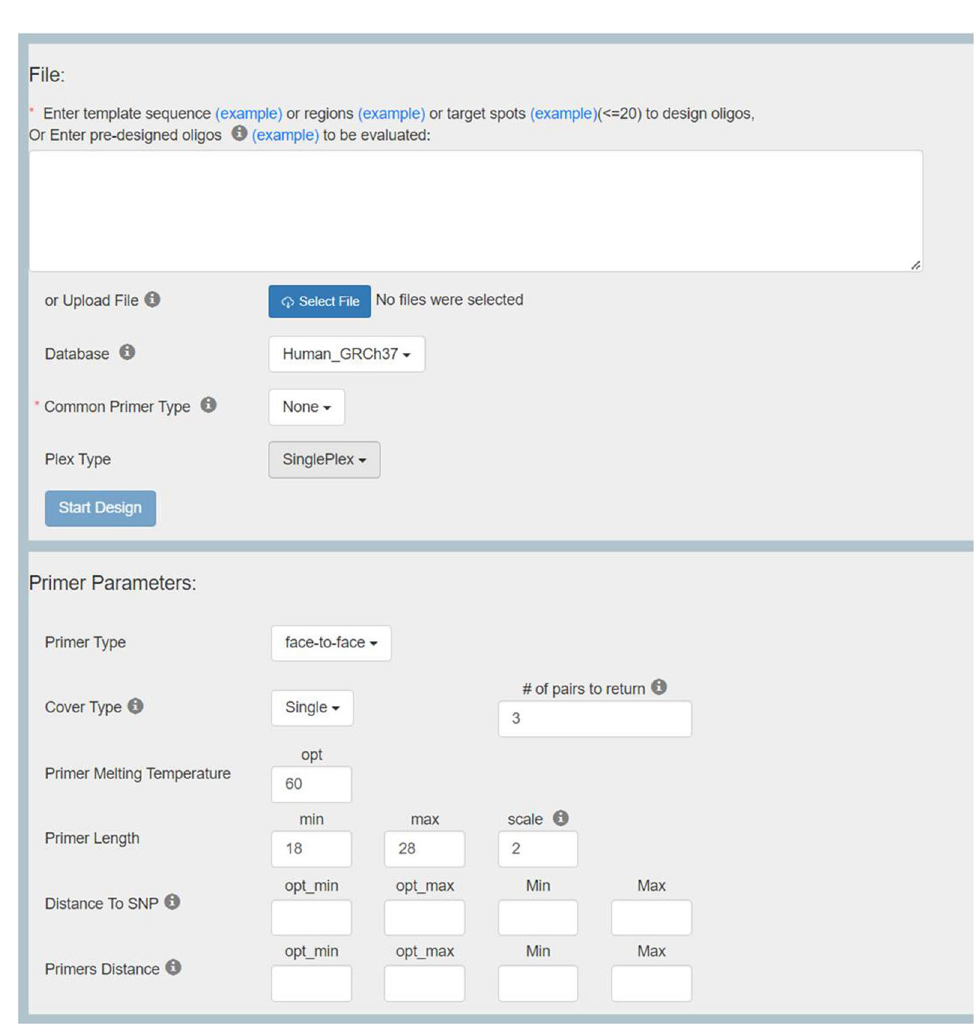
Figure 5. Web-based